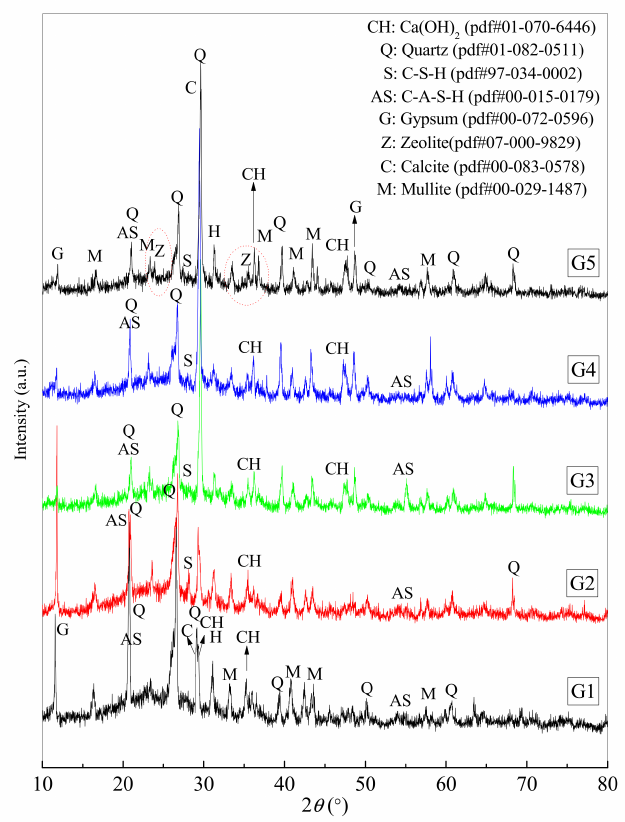
Figure 3. The XRD patterns of backfill paste (G5) and controls (G1, G2, G3, and G4) at 90